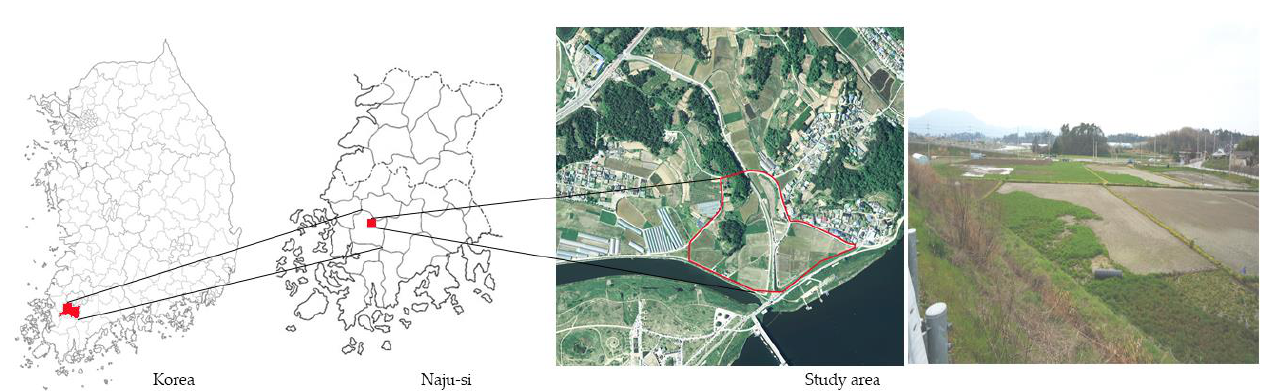
Figure 1. Research site location and landscape.